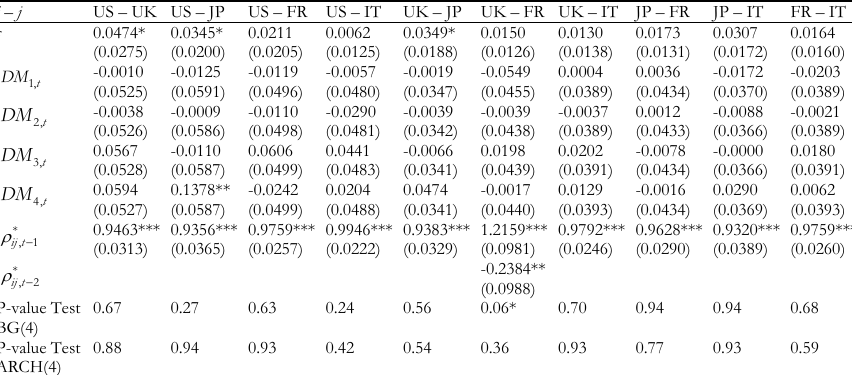
Results for the autoregressive model estimates with impulse dummy variables referred to the detected crisis